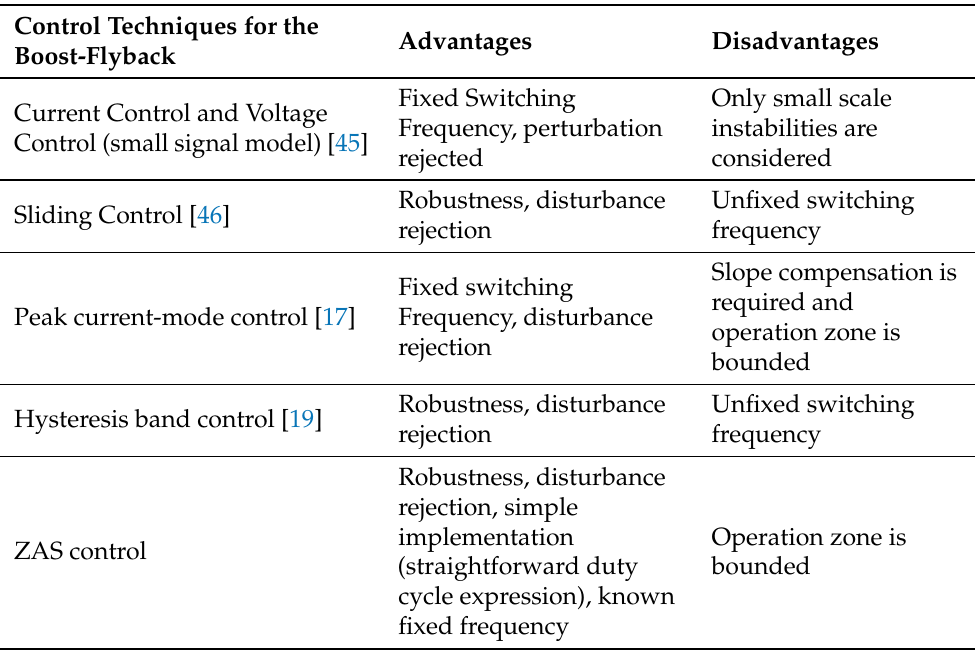
Table 3. Advantages and disadvantages of different control techniques used for the boost-flyback converter in the